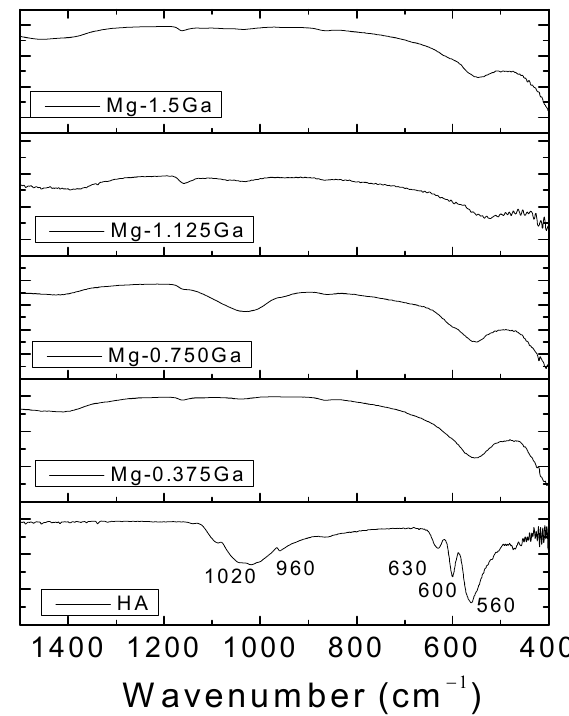
Figure 7. FTIR spectra of pure magnesium and Mg-Ga alloys after 168 h of immersion in SBF and FTIR spectrum of synthetic hydroxyapatite (HA) from 1400 to 400 cm −1 .